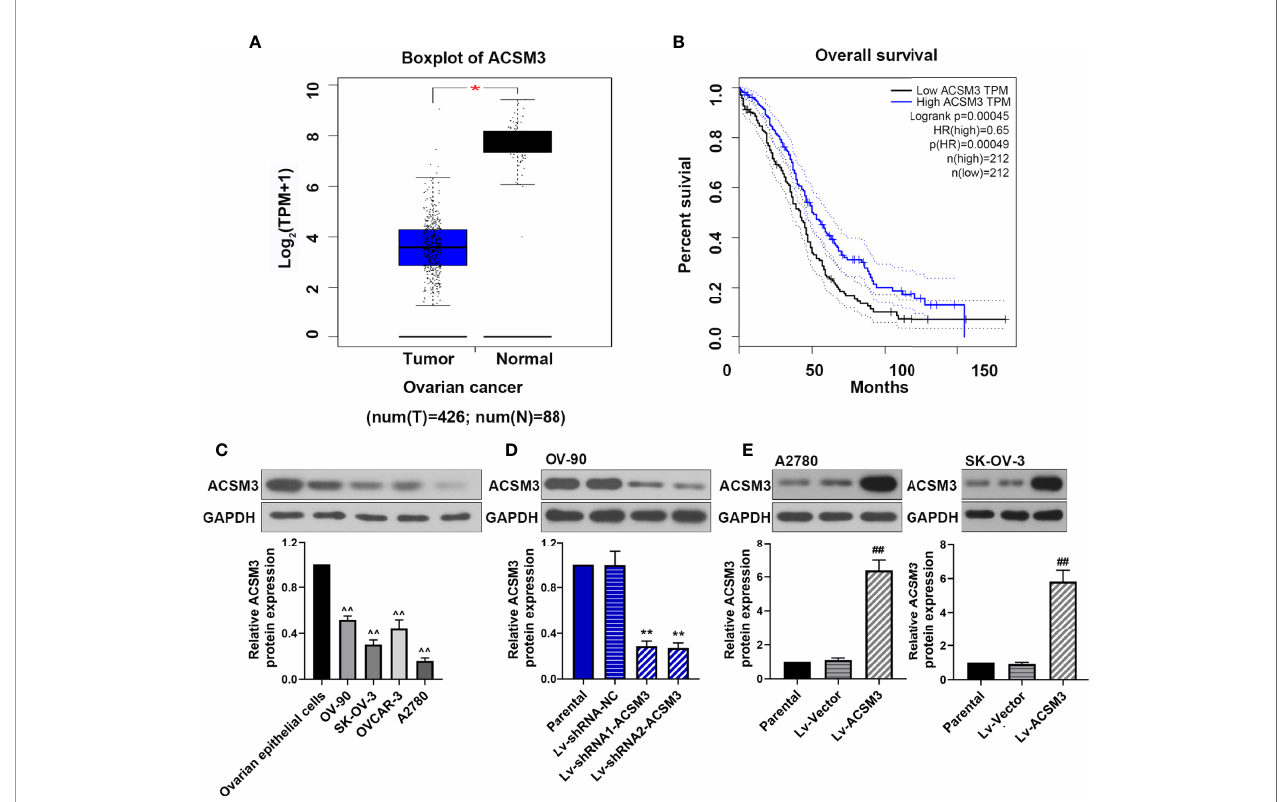
FIGURE 1 | The expression of ACSM3 and its co-relation of the overall survival of ovarian cancer. (A) Boxplot of ACSM3 in ovarian cancer. TPM, transcripts per kilobase of exon model per million mapped reads. (B) Overall survival time between patients with high and low ACSM3 expression. Dotted lines indicated the 95% con fi dence interval. HR, hazard ratio. (C) Relative protein expression of ACSM3 in ovarian epithelial cells and ovarian cancer cells: OV-90, SK-OV-3, OVCAR-3, and A2780 cells. (D) Relative protein expression of ACSM3 in Lv-shRNA-ACSM3 infected OV-90 cells (E) Relative protein expression of ACSM3 in Lv-ACSM3 infected A2780 or SK-OV-3 cells. Measurement data were expressed as mean ± SD of three independent experiments. ^^p < 0.01 versus ovarian epithelial cells; * p < 0.05, ** p < 0.01 versus Lv-shRNA-NC; ## p < 0.01 versus